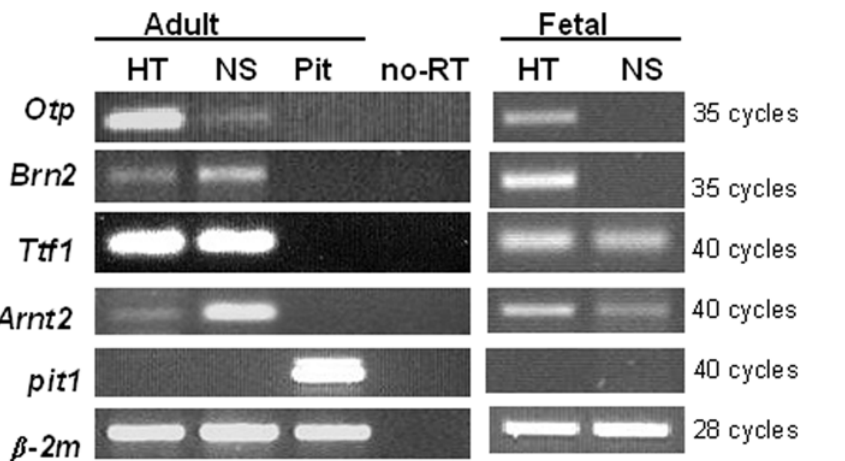
Figure 5. Hypothalamic-derived adult and fetal NS express some region-specific transcription factors. Gene expression analysis was determined by RT-PCR. RNA was isolated from adult and fetal tertiary NS cultures, adult and fetal hypothalami (HT) and adult anterior pituitary glands (Pit). Primers were designed to detect Otp (454 bp), Brn2 (390 bp), Ttf1 (128 bp), Arnt2 (162 bp), Pit1 (505 bp), and the housekeeping gene b -2m (142bp) used as control. The number of cycles performed for the PCR reactiones were indicated for each gene on the right